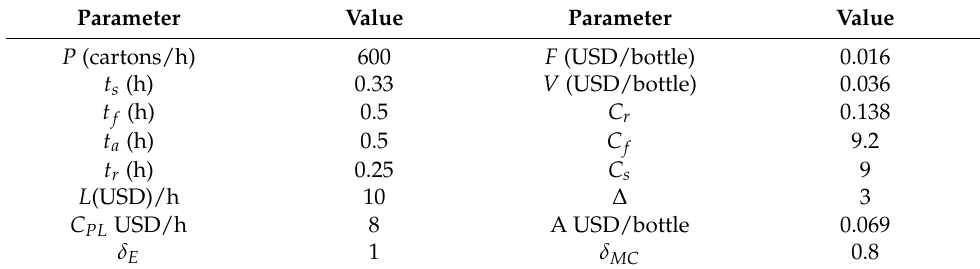
Table 3. An optimal set of decision variables for the proposed